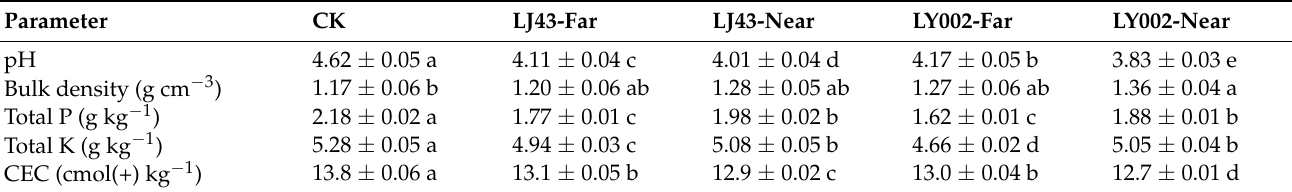
Table 2. Parameters indicating soil